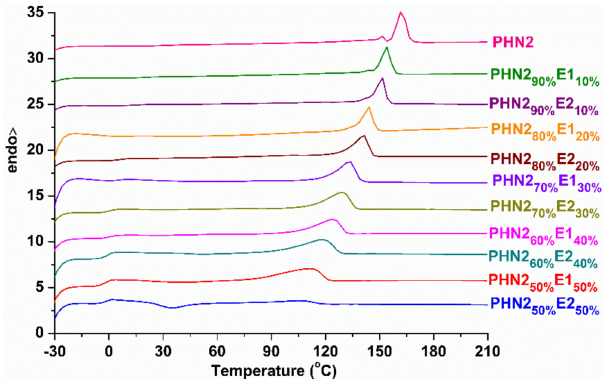
Figure 7. The second heating DSC curves for PHN2 1 − x E1 x and PHN2 1 − x E2 x after precipitating from methanol carried out from − 30 to 210 ◦ C at a heating / cooling rate of 10 ◦ C min − 1